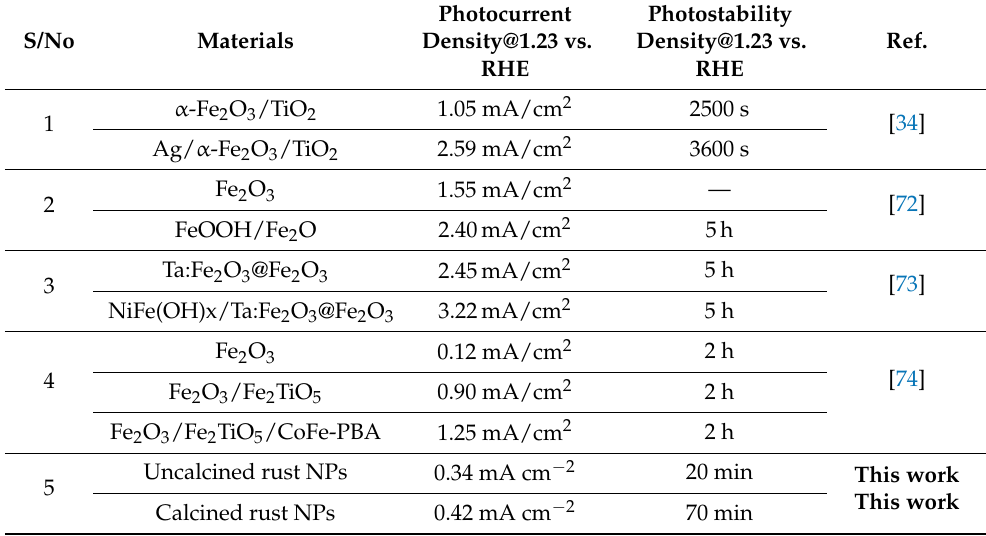
Table 2. Photocurrent densities and photostability of some reported hematite-based photoanodes. S/No Materials